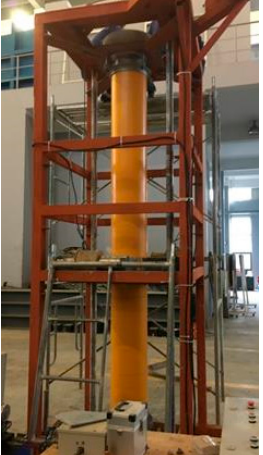
Figure 2. Magnetic vibration device.